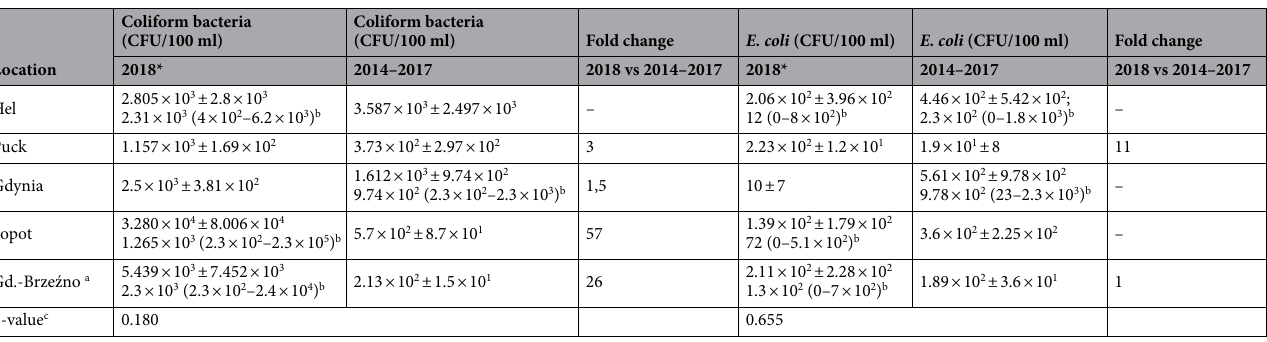
Table 2. The mean and standard deviation of concentration of coliforms and E . coli (CFU/100 ml) in sea- surface microlayer samples collected in the Bay of Gdansk in 2018 versus 2014–2017. a Gd.-Brzeźno—it is an abbreviation of the town name Gdańsk-Brzeźno, b in case of a higher standard deviation than the mean, the median and range (min–max) was calculated, c Friedman test, α-0.05, *The results marked in grey colour have been published in preliminary study 36 .